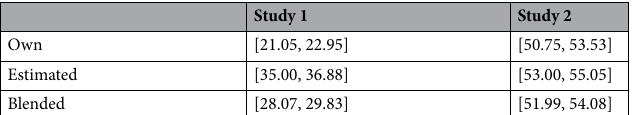
Table 1. Data structure across the two studies. This table shows a 95% confidence interval (CI) regarding the rating values. We computed the 95% CI by bootstrapping. In Study 1, the average rating values for all types of opinions were below half, while in Study 2, they were around half.